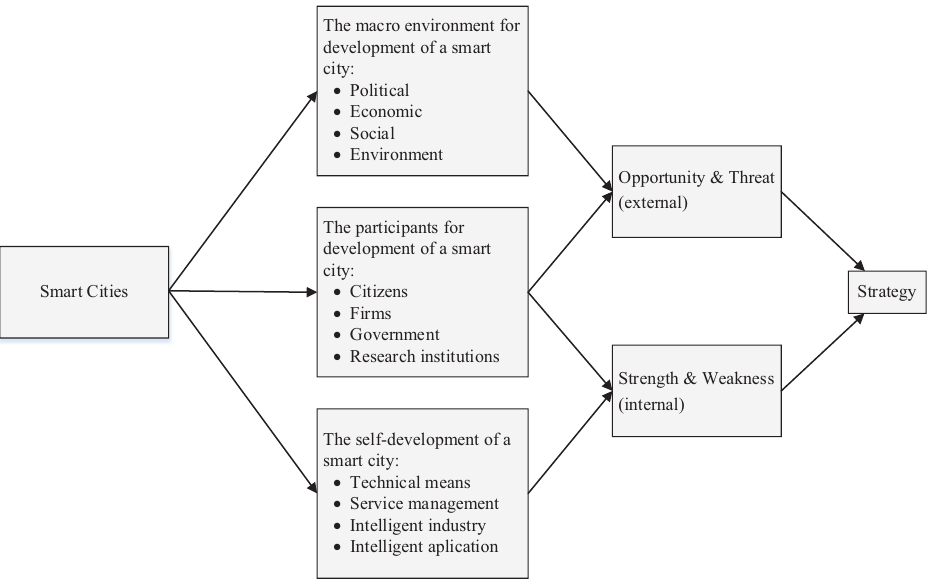
Figure 4. The path to identify SWOT